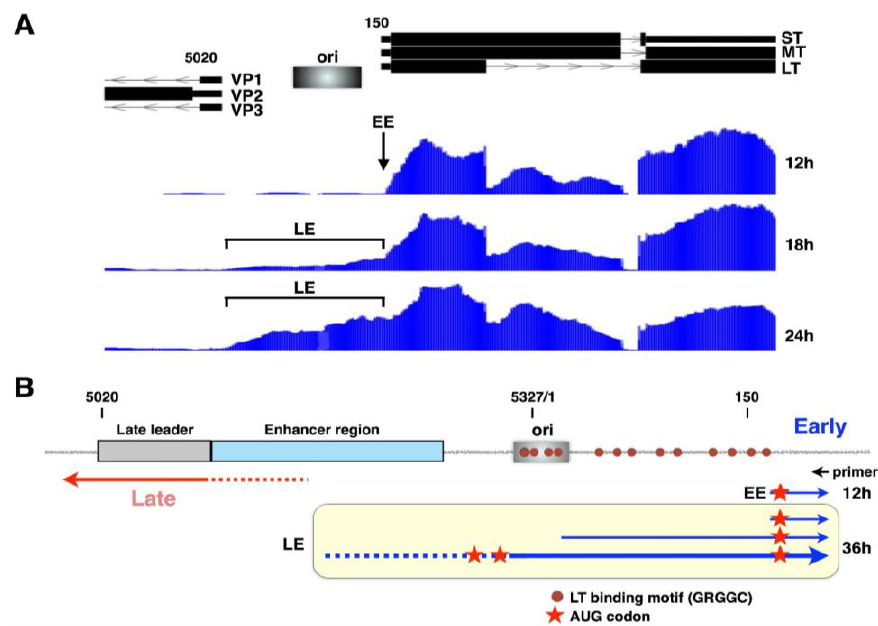
Figure 6. Early-strand transcription start sites shift after the onset of viral DNA replication. ( A ) An expanded view of the intergenic region is shown, along with genome browser tracks showing the alignment of early-strand RNAs at several times after infection, as reported by us recently [20]. These data were confirmed using the 5′-rapid amplification of cDNA ends (RACE) analysis [20]. Note the dramatic shift from 5′-ends mapping to a specific site at early times (EE) to many upstream sites at later times (LE); ( B ) The intergenic region is depicted, along with a general cartoon of early-strand RNAs at early times (EE) and early-strand RNAs at late times (LE). Positions of large T antigen binding are shown, along with the palindromic core replication origin, the enhancer region and the late transcription start site region. Red stars denote AUG codons that could direct translation initiation. Those in LE but not EE transcripts are frameshifted relative to the early coding region.